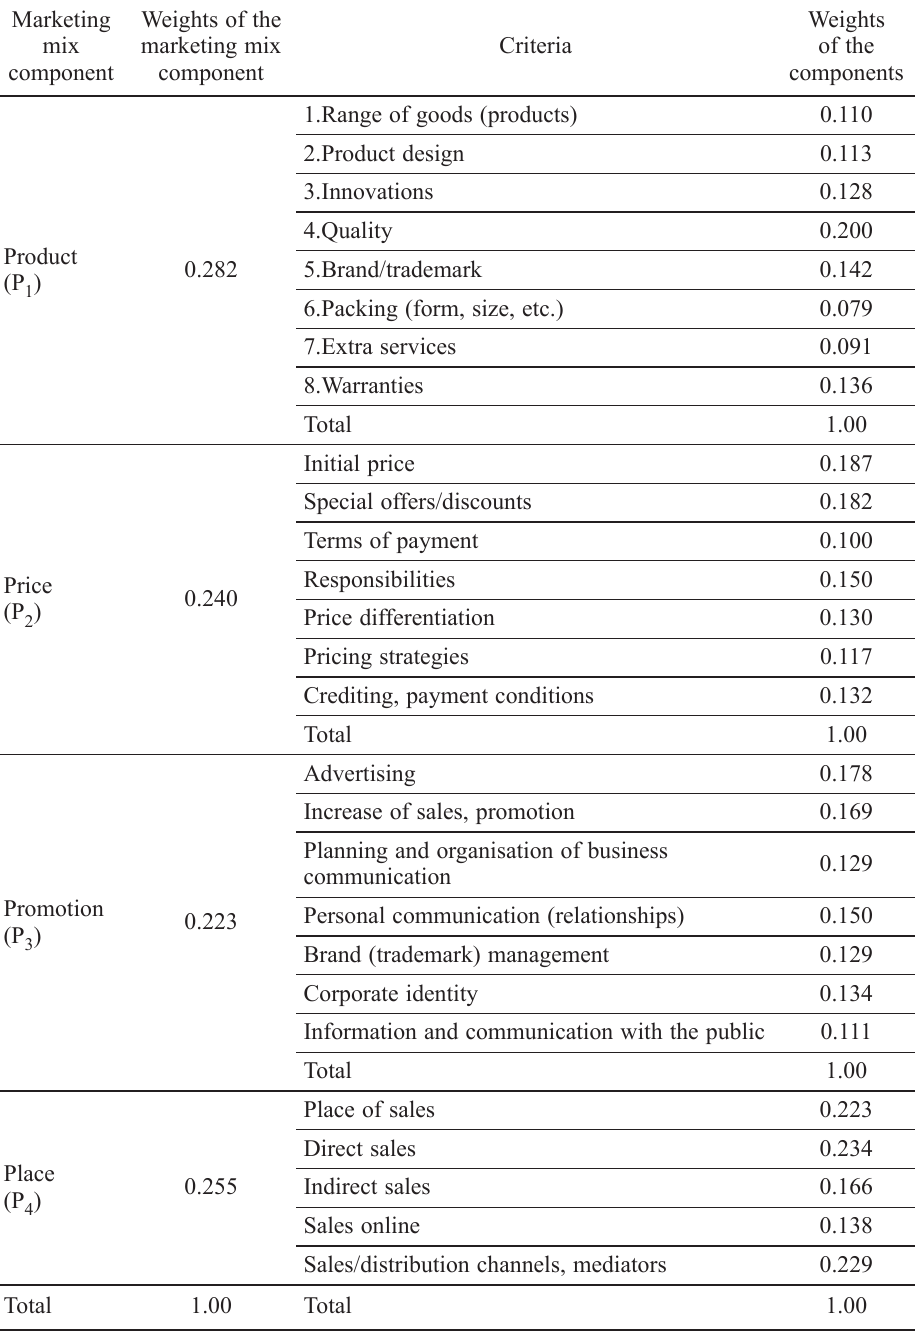
Table 2 . Weights of the components of enterprise marketing system described by the hierarchical set of